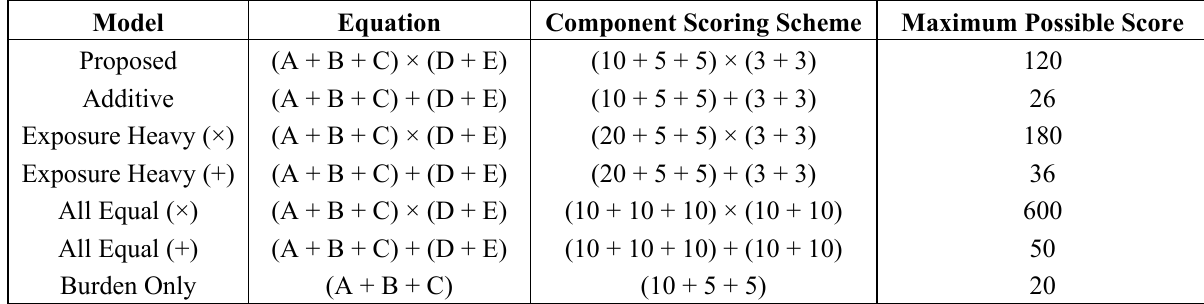
Table 2. Alternative models used in the sensitivity analysis 1 .